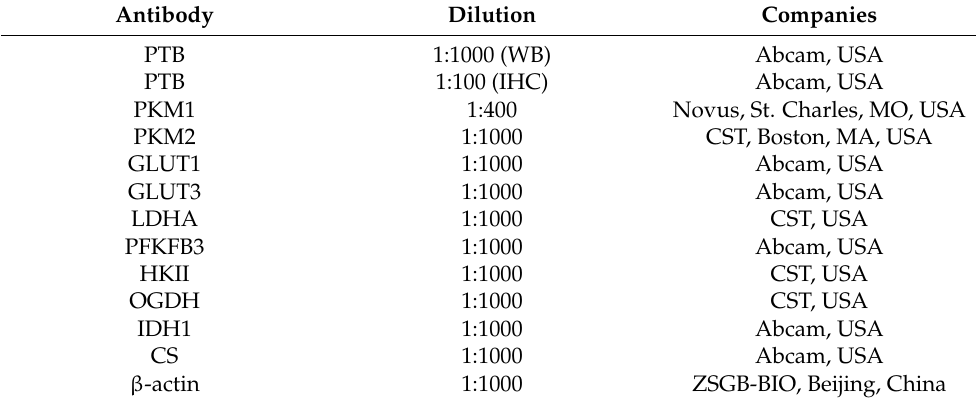
Table 3. Information on the